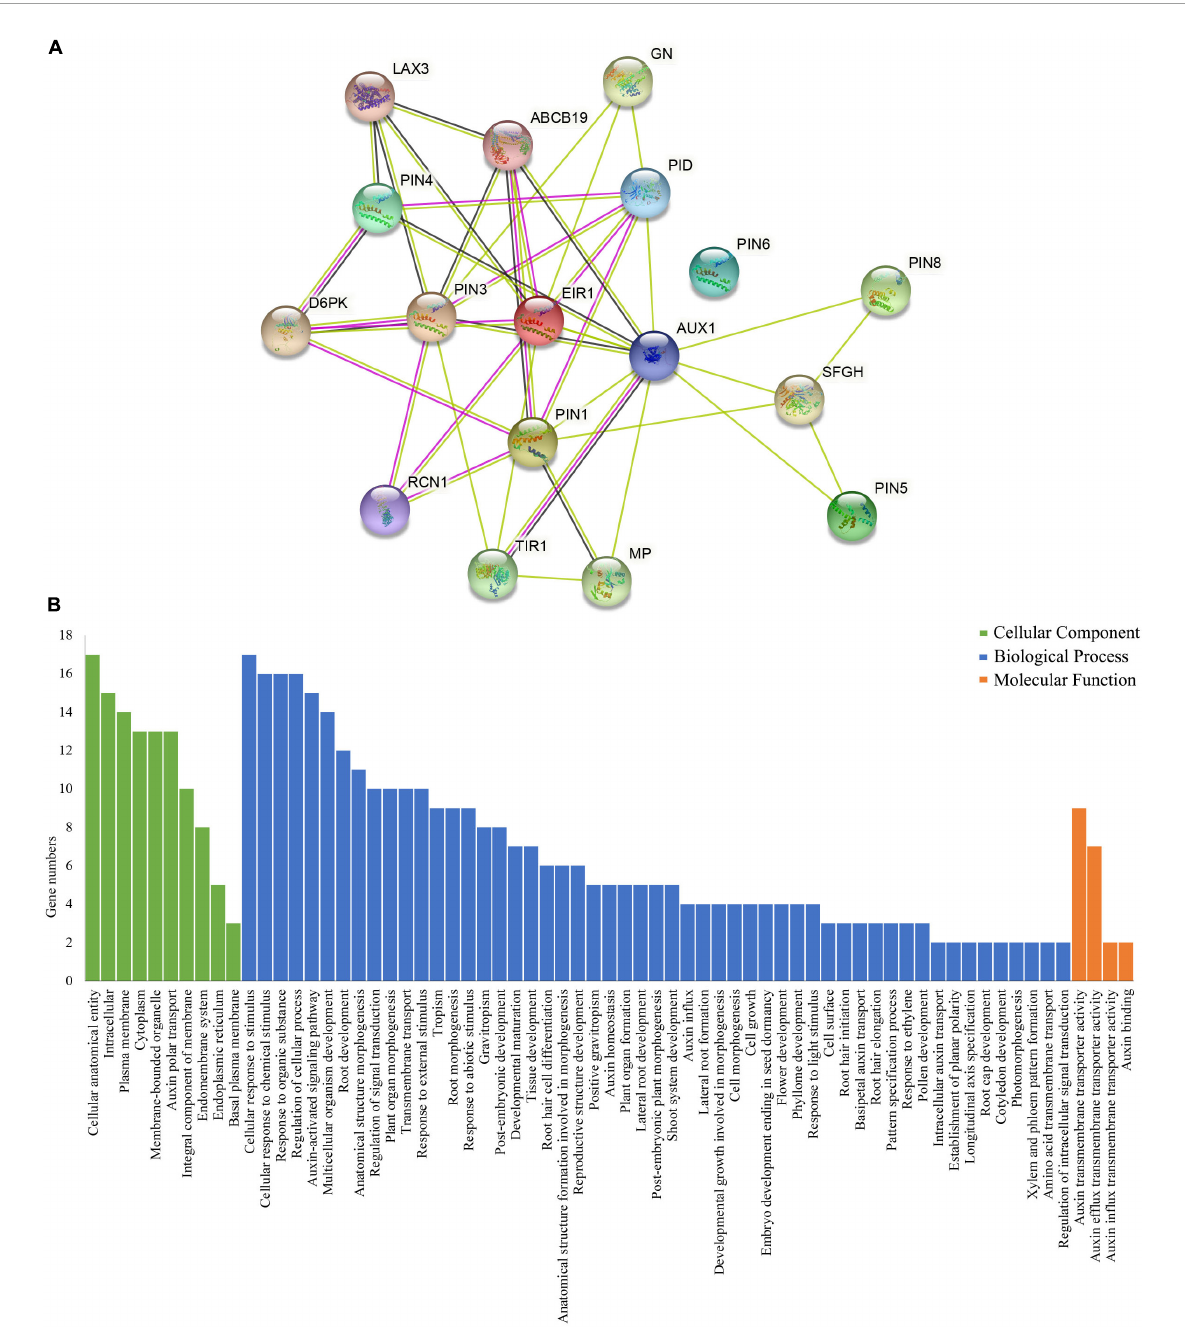
FIGURE5 (A) QQProtein–protein interaction (PPI) network of PIN-formed (PINs) and (B) gene ontology (GO) annotation of proteins in the